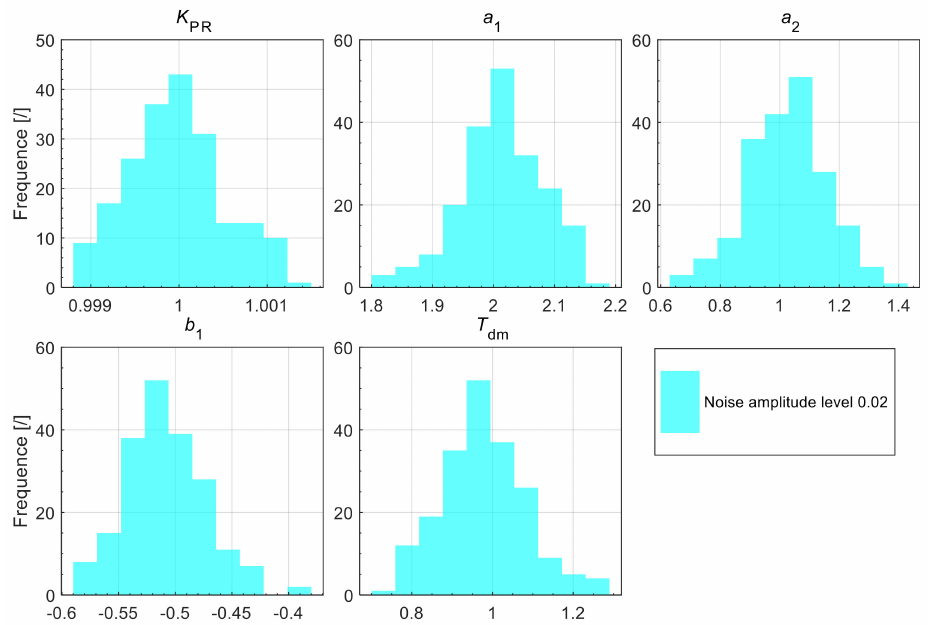
Figure 27. Histograms of the calculated process model parameters.